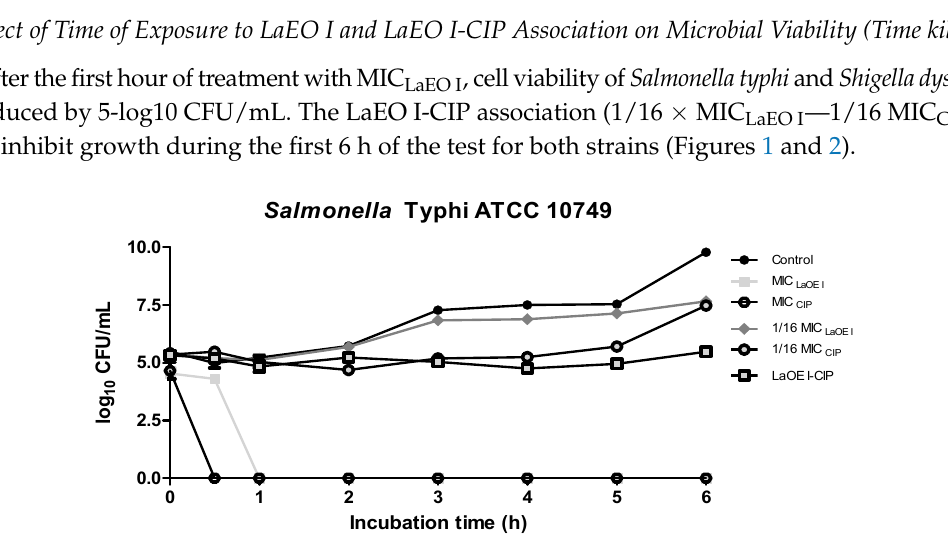
Figure 1. Effect of time of exposure to LaEO I and the LaEO I-CIP association on the viability of Salmonella typhi ATCC 10749. Values are expressed as mean ± SEM of two assays. The analysis was performed by Analysis of Variance (ANOVA), with Dunnett’s post-test and p value < 0.05 when compared to the control. Control: culture medium + microorganism; MIC LaEO I = 1 mg/mL; MIC CIP = 0.25 μg/mL; FICI LaEO I-CIP = 0.125 (lower concentrations of LaEO I and CIP in the association, with antimicrobial activity = 1/16 × MIC).